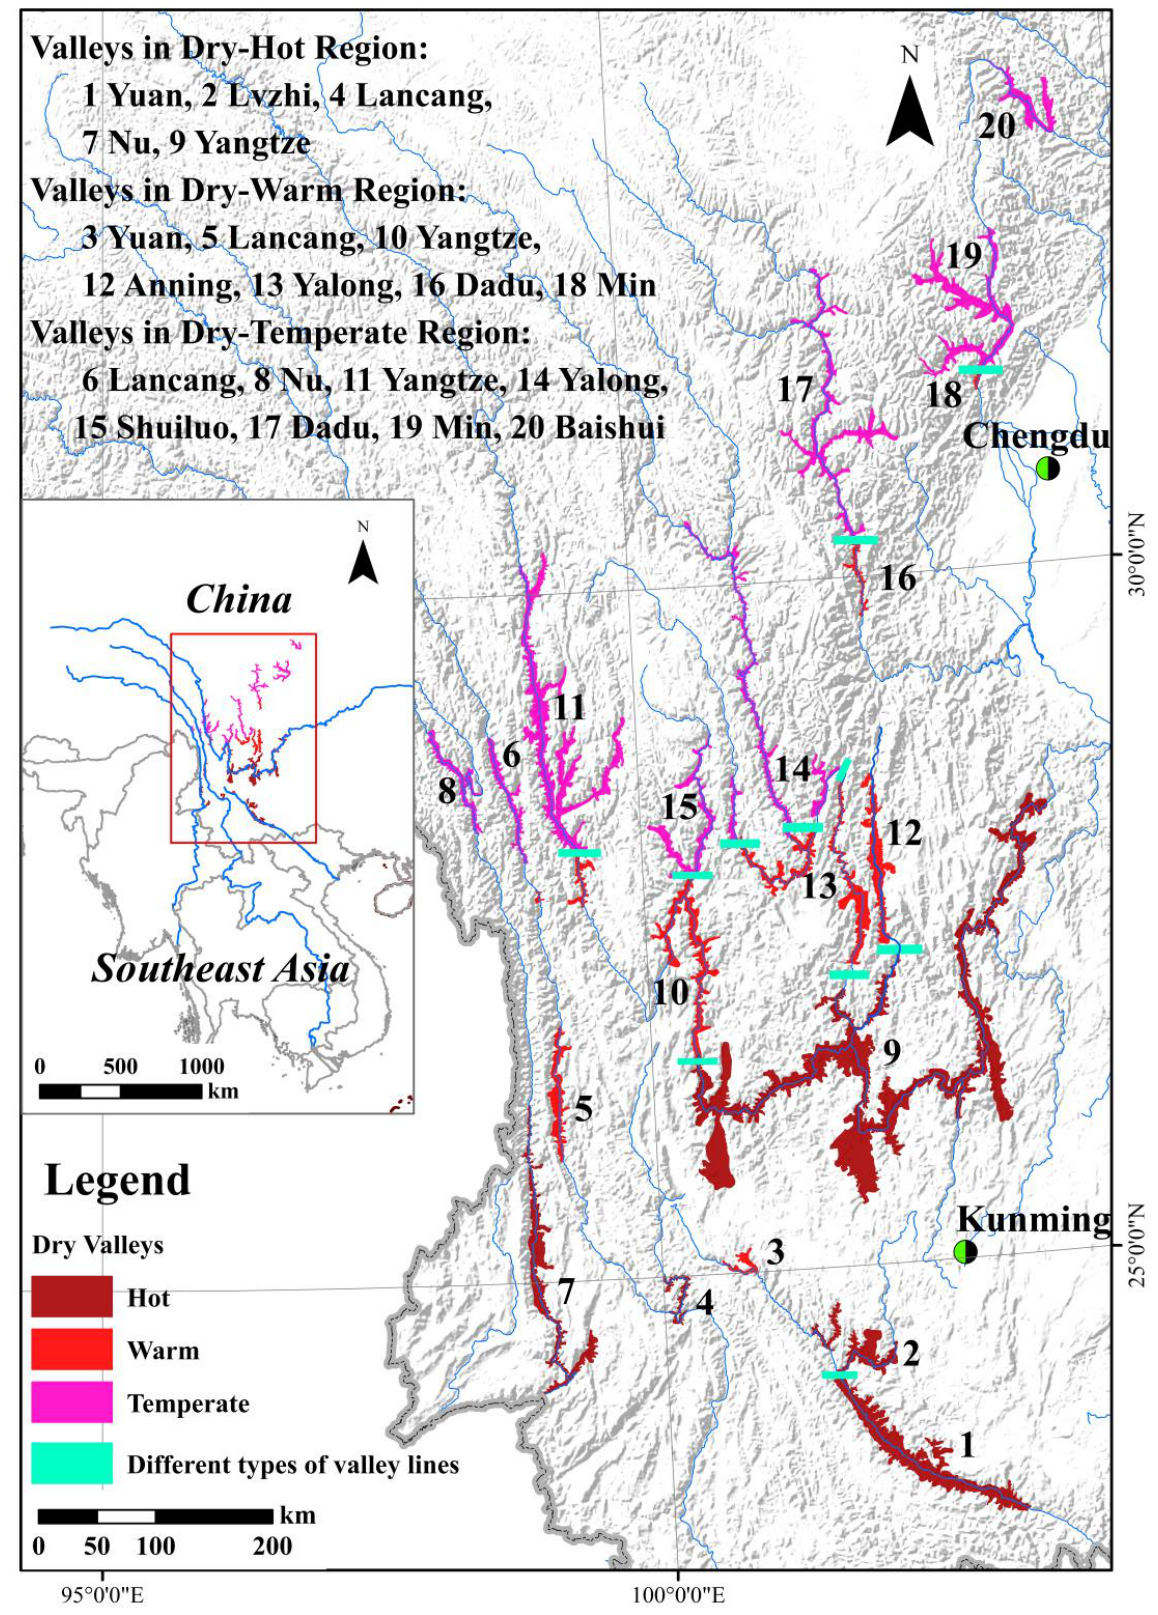
Figure 1. Geographical distribution of dry valleys in Southwest China. Table 2. Basic information of 20 main dry valleys in Southwest China.